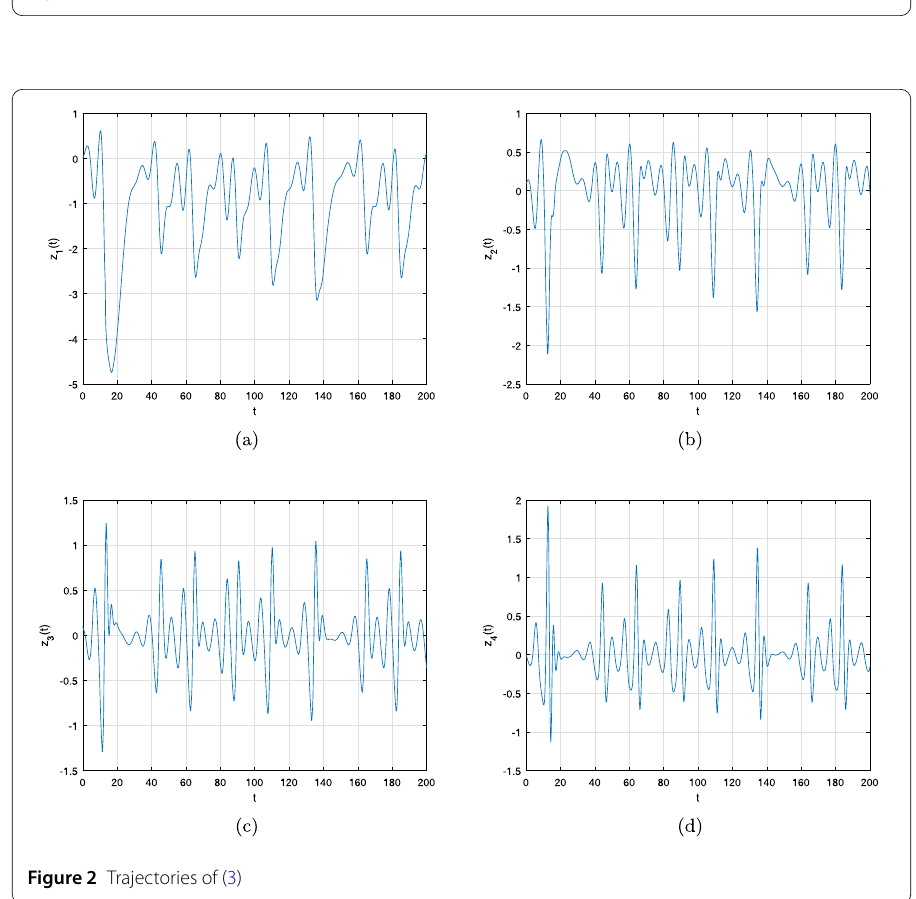
Figure 2 Trajectories of